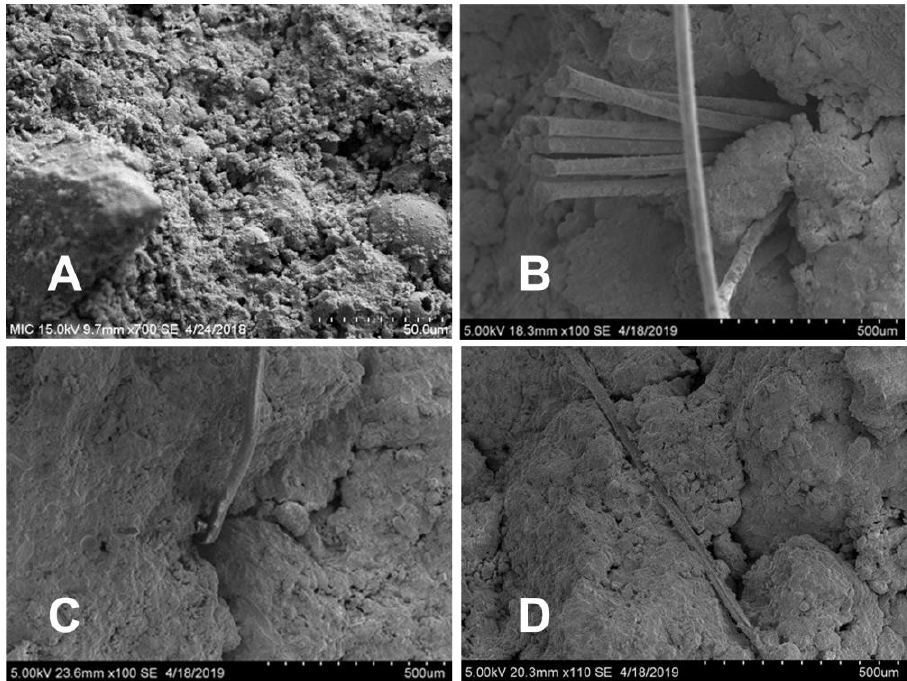
Figure 2. SEM images of four types of CSEB: without fibers ( A ), with PVA ( B ), with polyester ( C ) and with kenaf fibers ( D ).